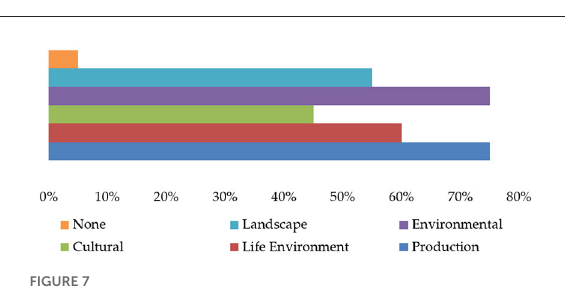
FIGURE7 Opinions regarding the importance of peri-urban agricultural landscapes in the urban agglomeration of Sousse. Own